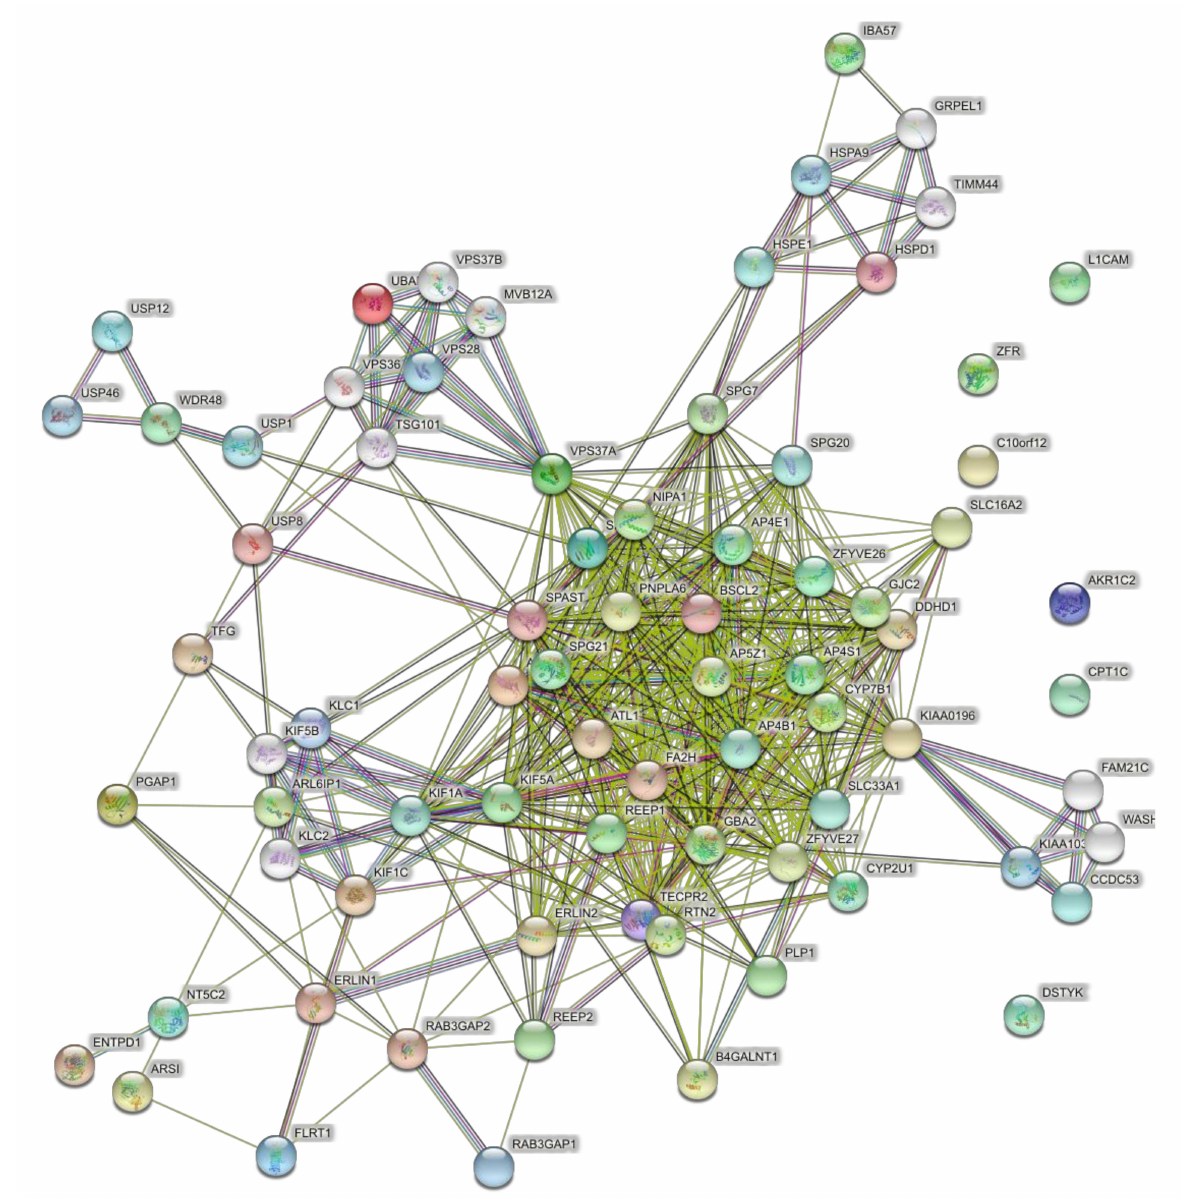
Figure 7. Predicted PPI networks for second shell interactions among 57 genes of pure and complicated